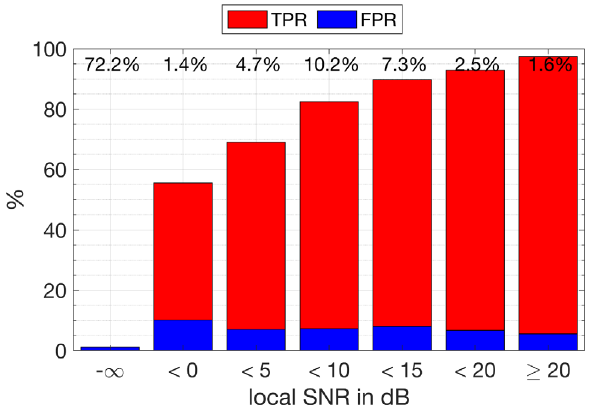
Figure 3. TPR and FPR for the real-world recordings of one person, dependent on the local SNR. A local SNR of (cid:2)1 indicates intervals without OVS. The numbers above each bar represent the portion of the recording with the corresponding local